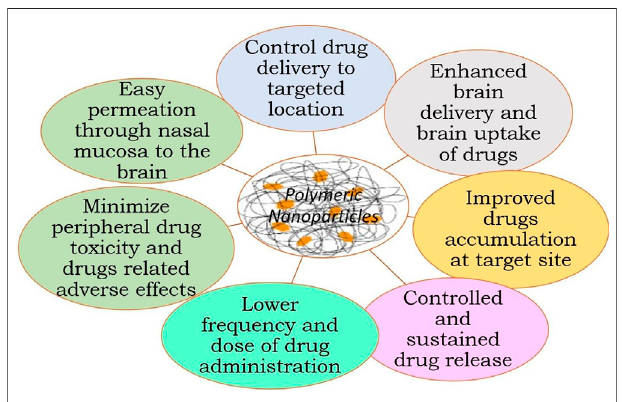
FIGURE 4 | Application of polymeric NPs in brain delivery. NPs,